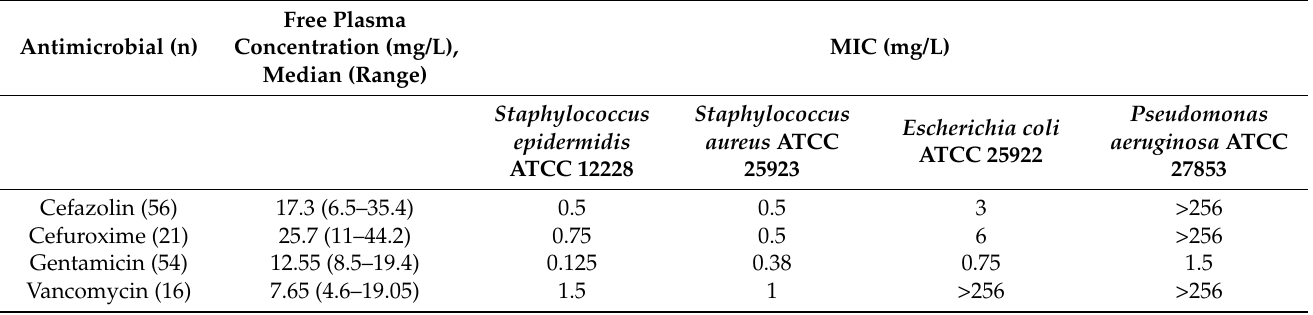
Table 5. Antibiotic plasma levels in surgical procedures with positive ( n = 53) and negative ( n = 40) intraoperative cultures and MICs of antimicrobial agents used in prophylaxis against ATCC reference strains.